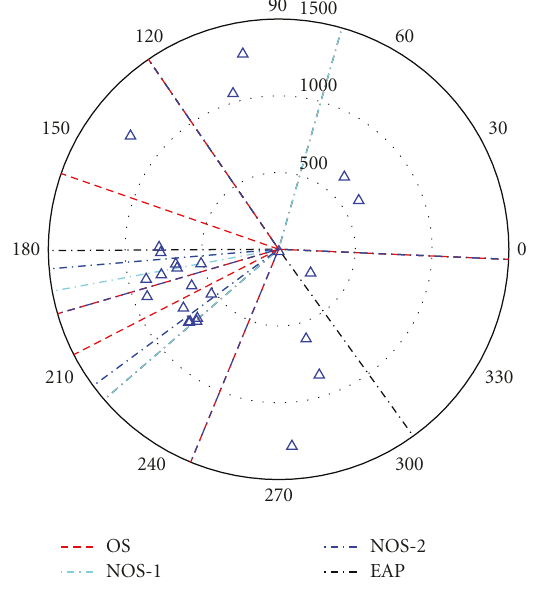
Figure 9: Sector boundaries for the downlink of a CDMA system with nonuniform user distribution. Number of users, M = 25; pro- cessing gain, K = 6; number of sectors, K = 6. Table 3: Results for the system in Figure 6.